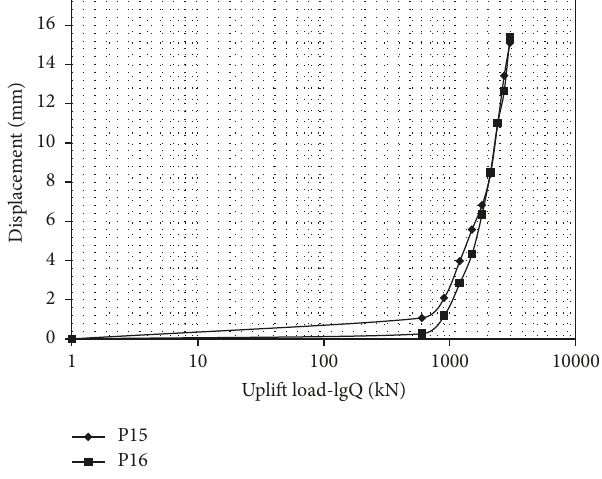
Figure 10: Results of S-lgQ curvature.